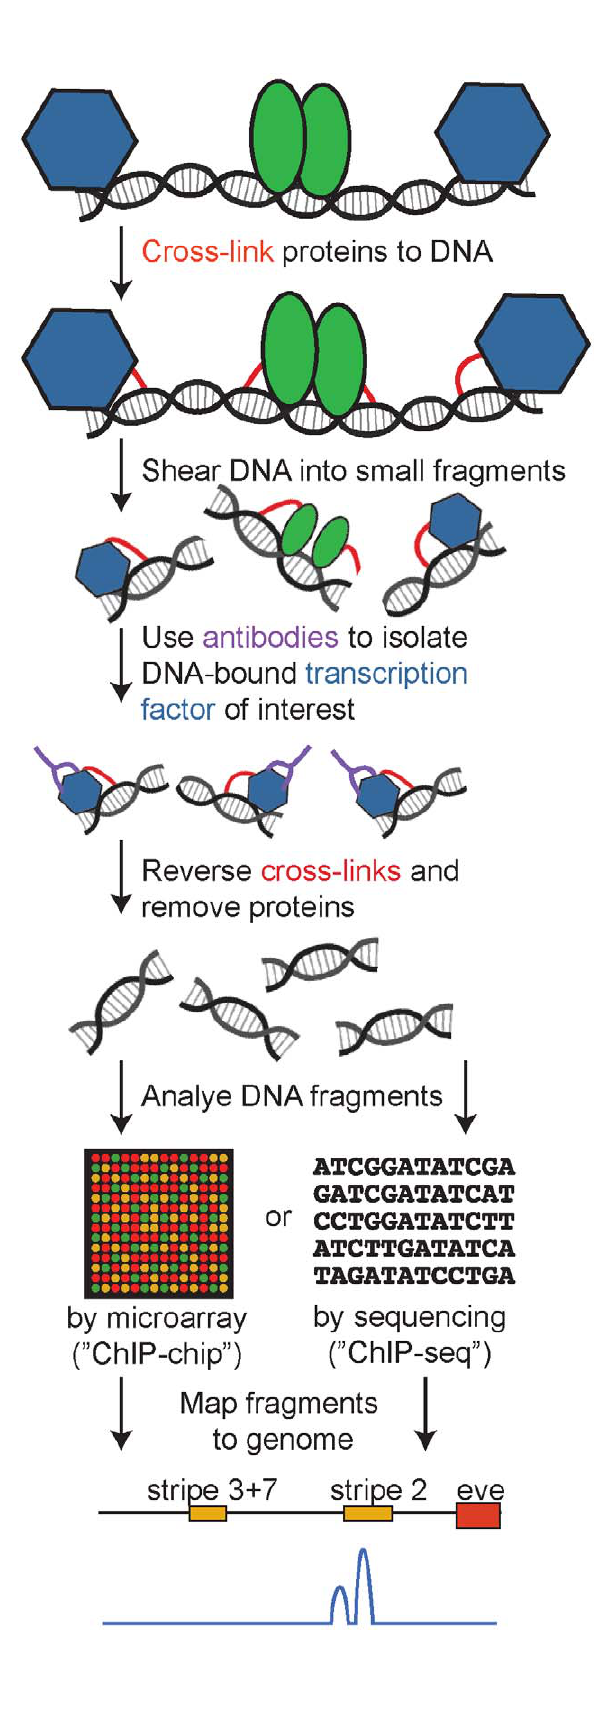
Figure 1. ChIP-chip and ChIP-seq reveal transcription factor binding genome-wide. DNA fragments bound by a transcription factor of interest (represented by blue hexagons) are recovered as shown. After mapping each DNA fragment to the genome, the relative frequency of each base within the recovered pool of DNA is summarized as a histogram. An example of such a histogram is shown in blue at the bottom of the figure for the 5 9 region of the Drosophila even-skipped ( eve ) gene containing the enhancers that drive expression in embryonic stripes 2, 3, and 7. The shape of this histogram mimics ChIP-seq data for binding of the Giant transcription factor in D. melanogaster and D. yakuba , as shown in Figure 1A of [19].